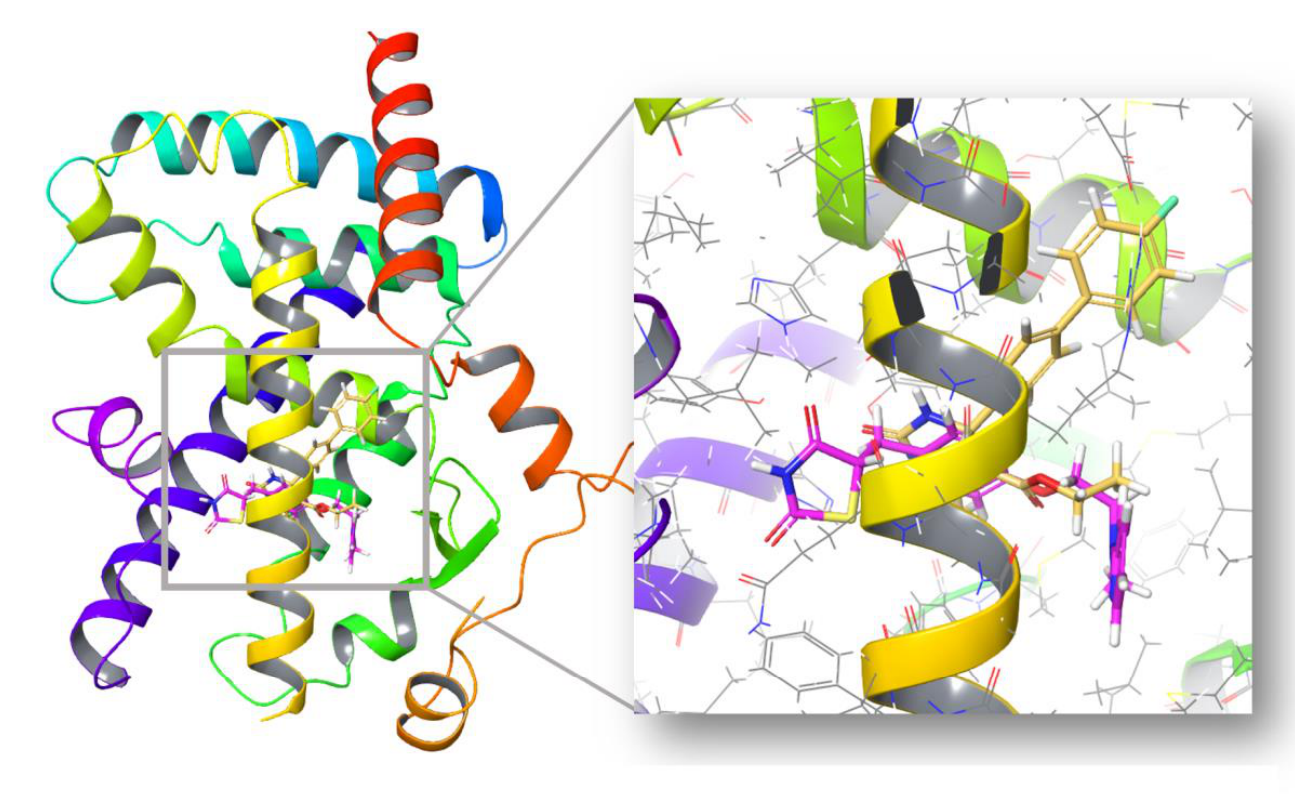
Figure 5. Cartoon representation of the cross-docked ligand (CL) and protein complex.